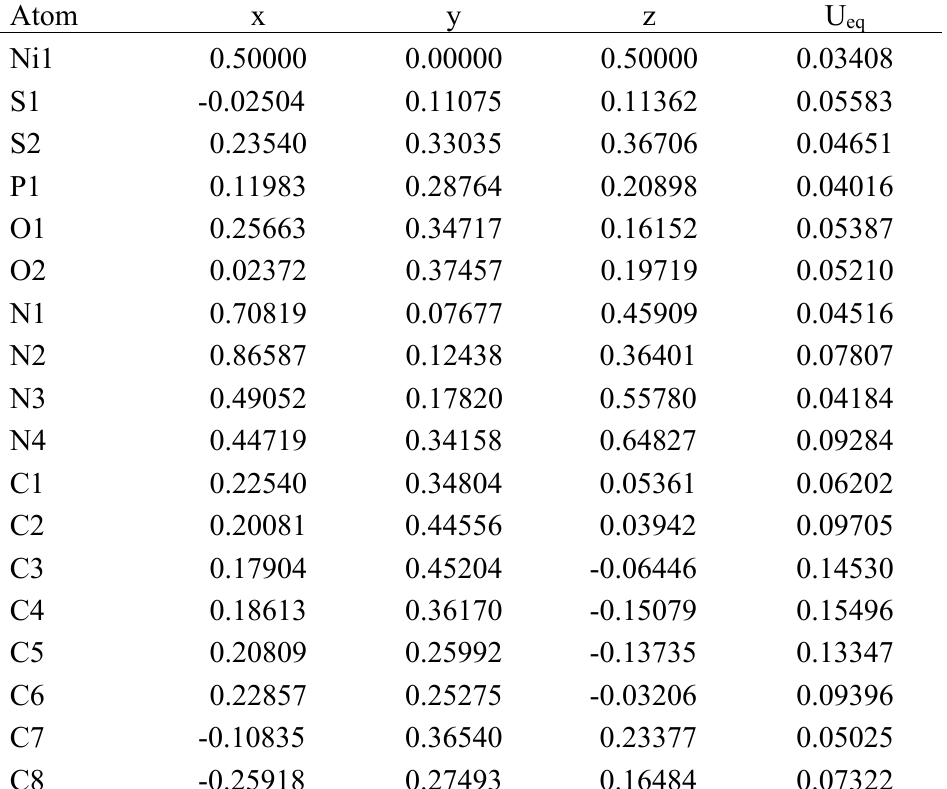
Table 1 Atomic coordinates and equivalent isotropic displacement